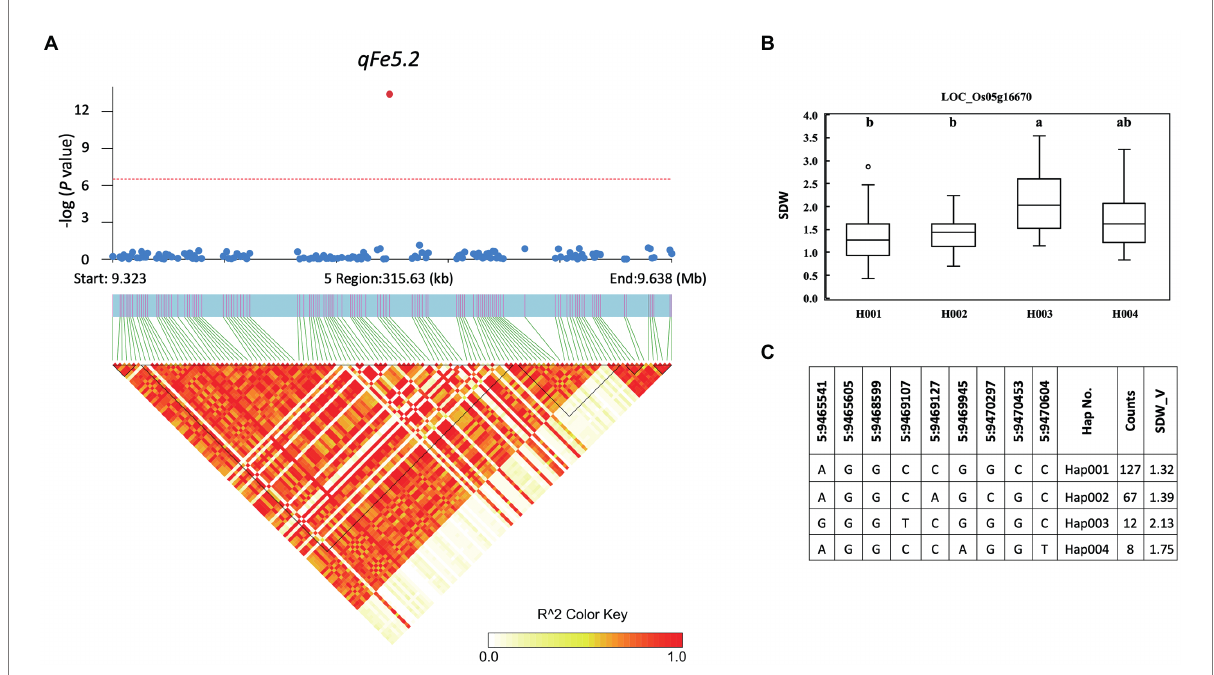
FIGURE 7 Associated regions and haplotype analysis of qFe5.2 . (A) Regional Manhattan plots and LD heatmap across the 315-kb region surrounding the significant SNP. The single red dot above the red line denotes the significant SNP. The black triangles in the LD heatmap represent the haploblocks. (B) Boxplots show the phenotypic distribution of SDW in the LOC_Os005g16670 haplotype groups. Different letters above each haplotype group show significant difference at p ≤ 0.05 according to Tukey’s HSD test. (C) Haplotype analysis of LOC_Os005g16670.